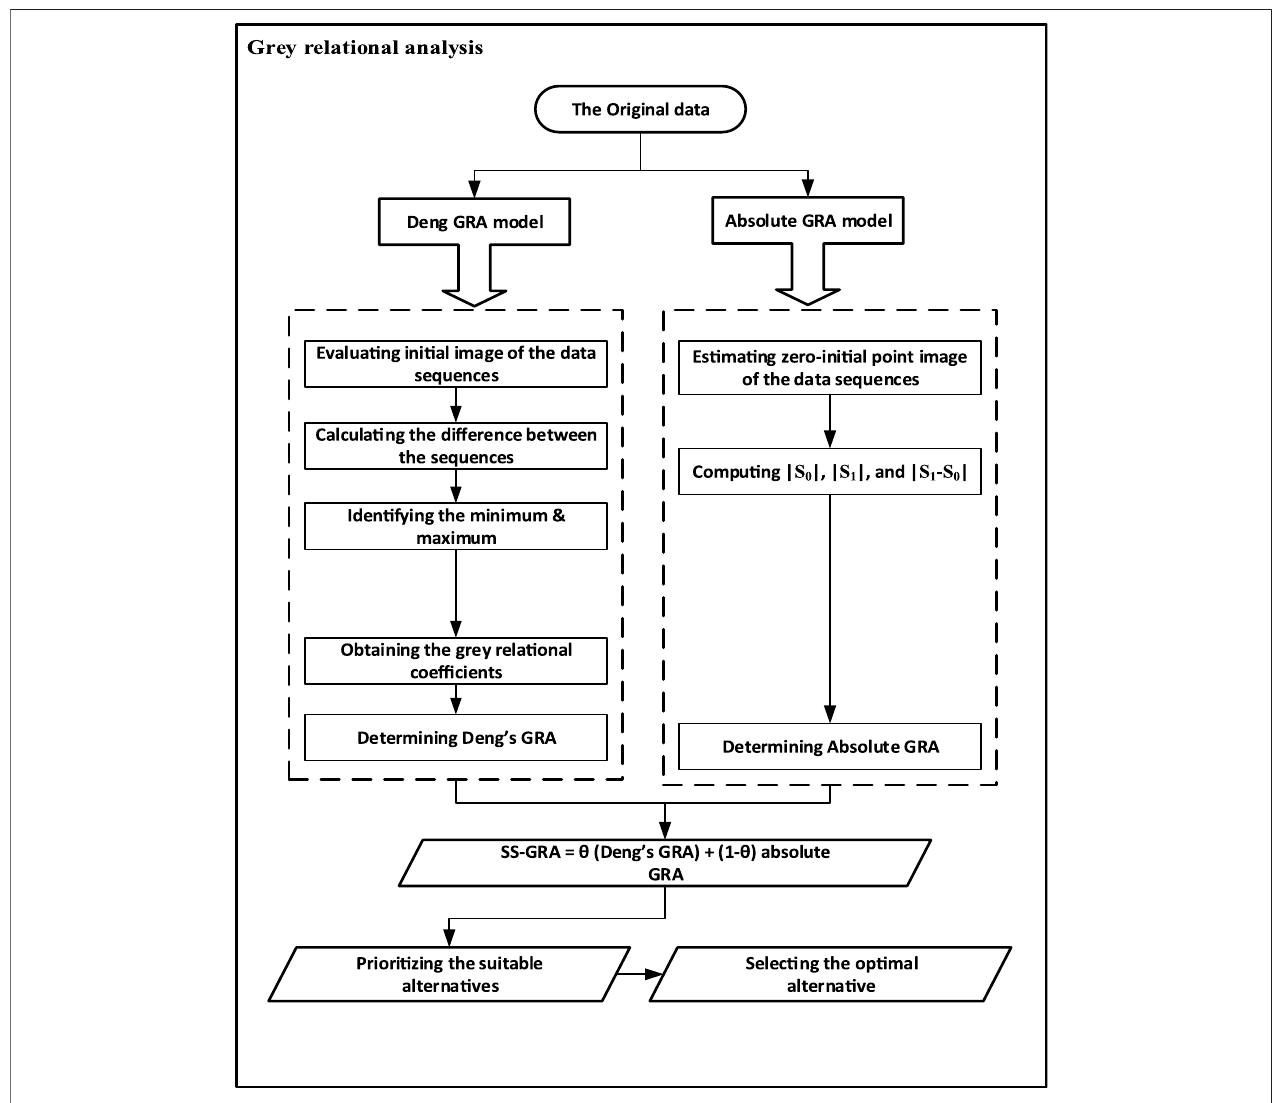
FIGURE 2 | Framework for the proposed grey